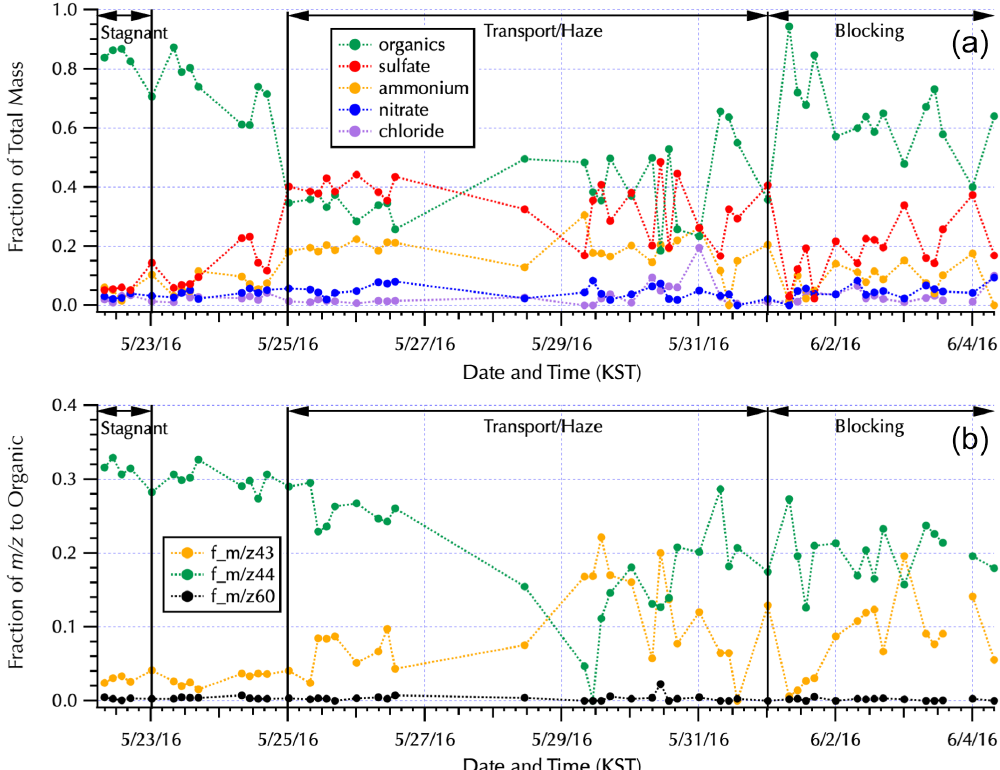
Figure 3. The fraction contributed to the total mass measured by AMS by each of the major aerosol components (a) and the fraction of key water-soluble organic mass fractions to the total AMS organic mass (b) for the complete filter set (Table S1) are shown within the context of the Peterson et al. (2019) meteorological regimes. Note that the long gaps between filters during the Transport/Haze period occurred as the ship transited South Korea’s territorial seas with samples obtained when the ship was outside of those waters. The single filter obtained along the south coast (Fig. 1) is the isolated data point on 28 May. The Transport/Haze samples collected from 25–26 May were obtained to the east of the peninsula, and those from 29–31 May were obtained to the west, representing downwind and upwind samples with respect to South Korean emissions and local atmospheric processing, respectively, under the prevalent atmospheric transport of this meteorological